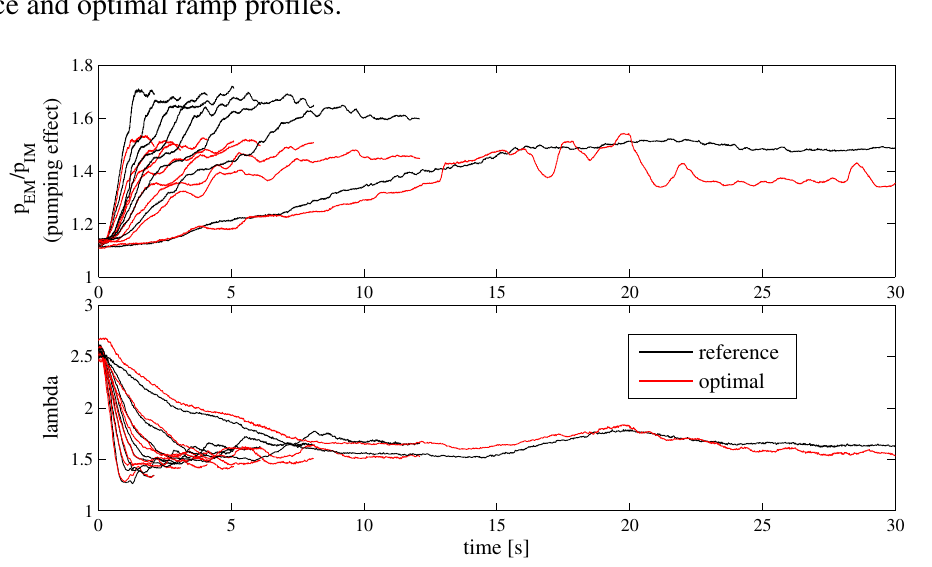
Figure 12. Comparison of the pumping effect and the air-to-fuel ratio (AFR) between reference and optimal ramp profiles.